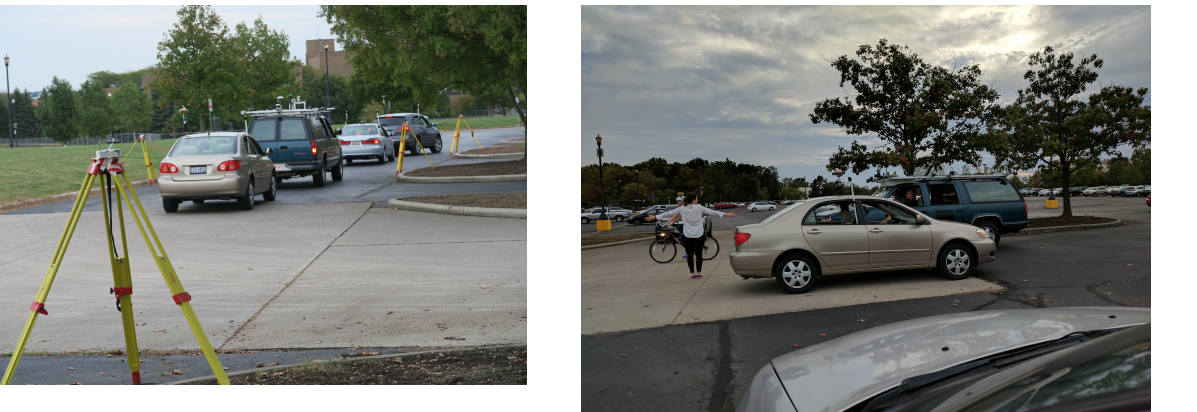
Figure 1. Example 1 of car configuration.